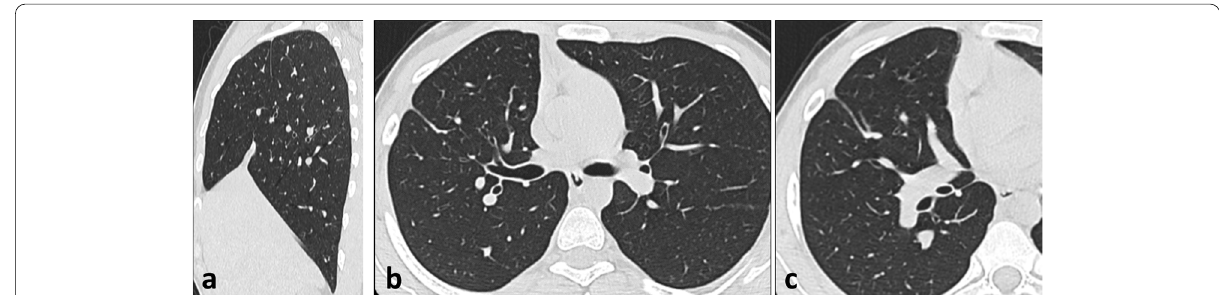
Fig. 3 CT chest in lung windows. a Sagittal image shows discontinuous right oblique fissure. Superior segment of right lower lobe was seen extending up to the apex. b Axial image shows completely absent right upper lobe bronchi and pulmonary parenchyma. Discontinuous right oblique fissure was seen in the right perihilar region. Two bronchi were seen arising from the bronchus intermedius. c Axial image shows abnormal segmentation of the middle lobe. Medial segment and lateral segment bronchi of middle lobe seen supplying the lung anterior and posterior to the discontinuous oblique fissure